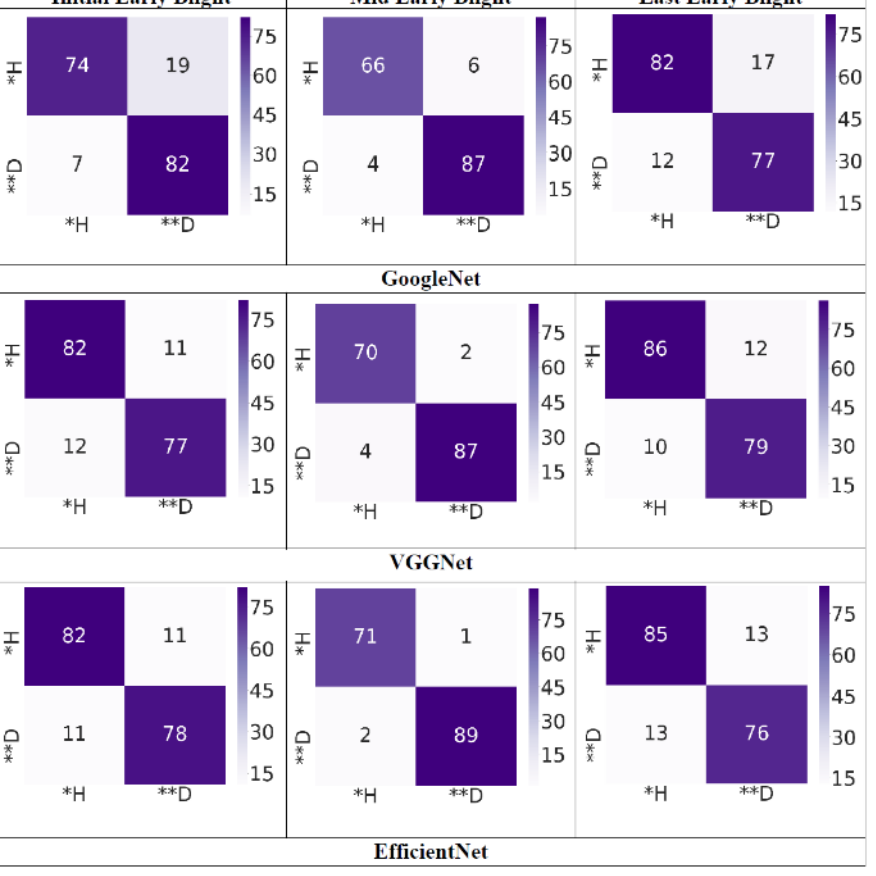
Figure 3. Confusion matrices of 2-Class convolutional neural networks, where * H = the number of actual and predicted healthy plants; ** D = the number of actual and predicted diseased plants.